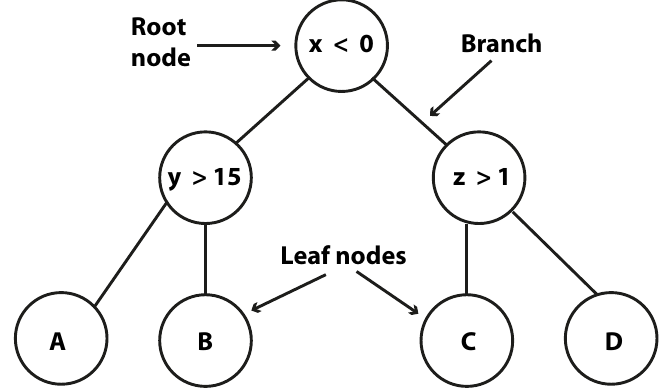
Figure 6. A simple decision tree sorting points on the { x , y , z } coordinate system. Points satisfying the conditions on each node proceed on the left branch, the rest proceed to the right branch. The